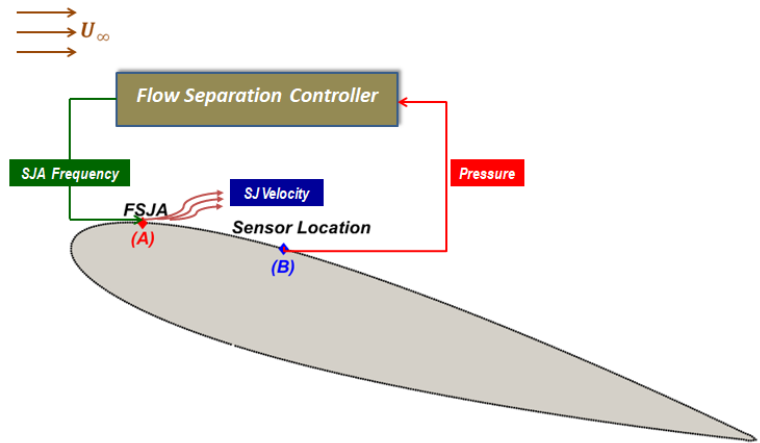
Figure 12. Schematic diagram for the flow separation control.